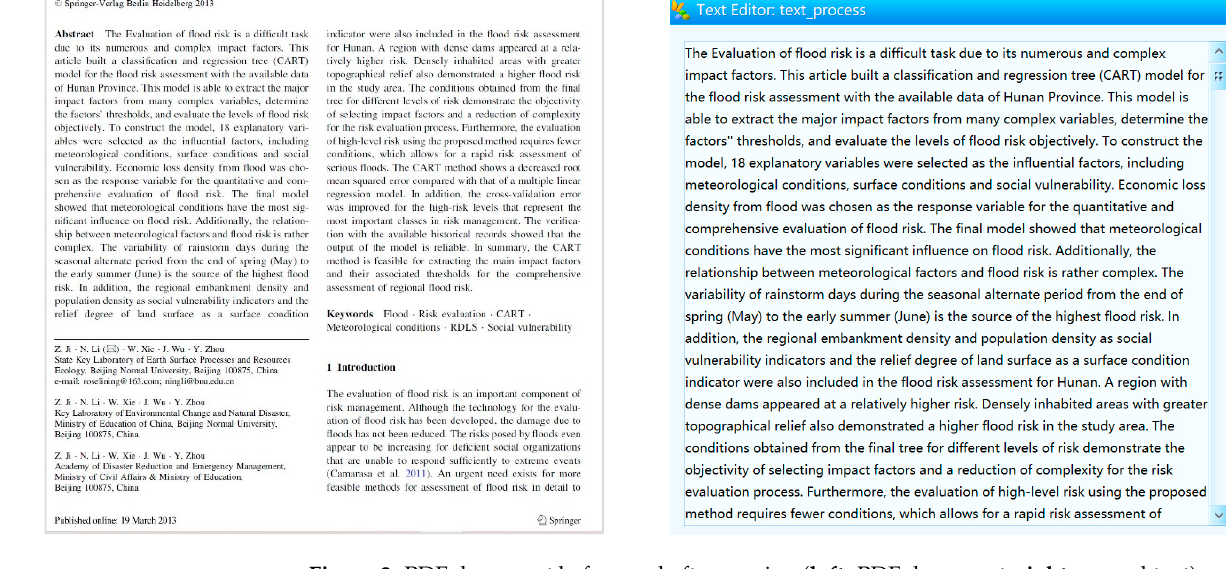
Figure 2. PDF document before and after parsing ( left : PDF document; right : parsed text).